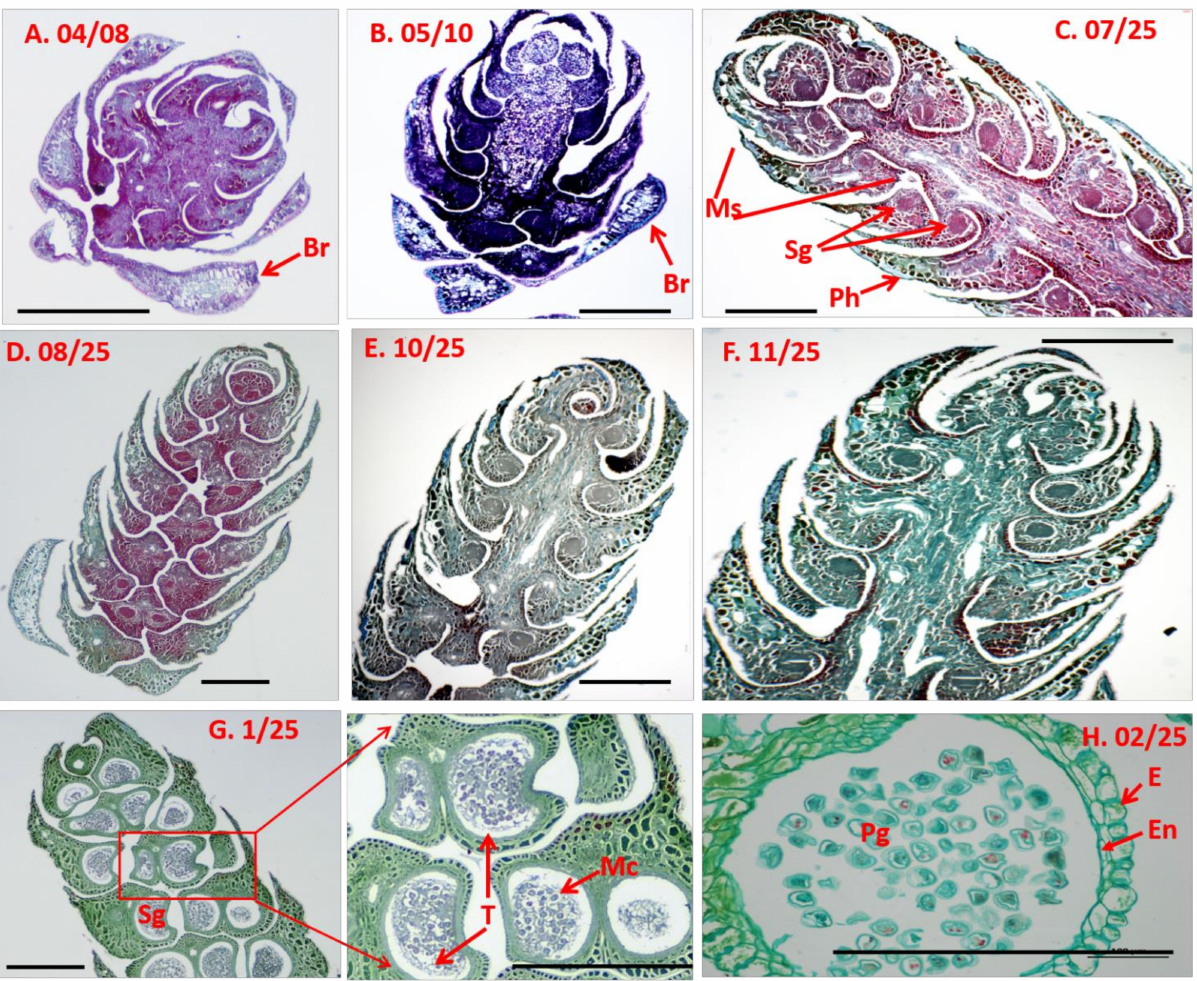
Figure 3. Longitudinal sectioning of D. pectinatum male cones at different developmental stages. ( A , B ): microspore pri- mordium formation stage (April to May); ( C – F ): microspore sac and pollen mother cell formation stage (July to November); ( G ): pollen mother cell division; ( H ): pollen grain formation (February). Br: bract; Sg: sporangia; Ph: phylloclade; Mc: mother cell; Ms: Microspore; Pg: pollen grain; T: tapetum; En: endothecium; E: epidermis; Bars = 500 µ